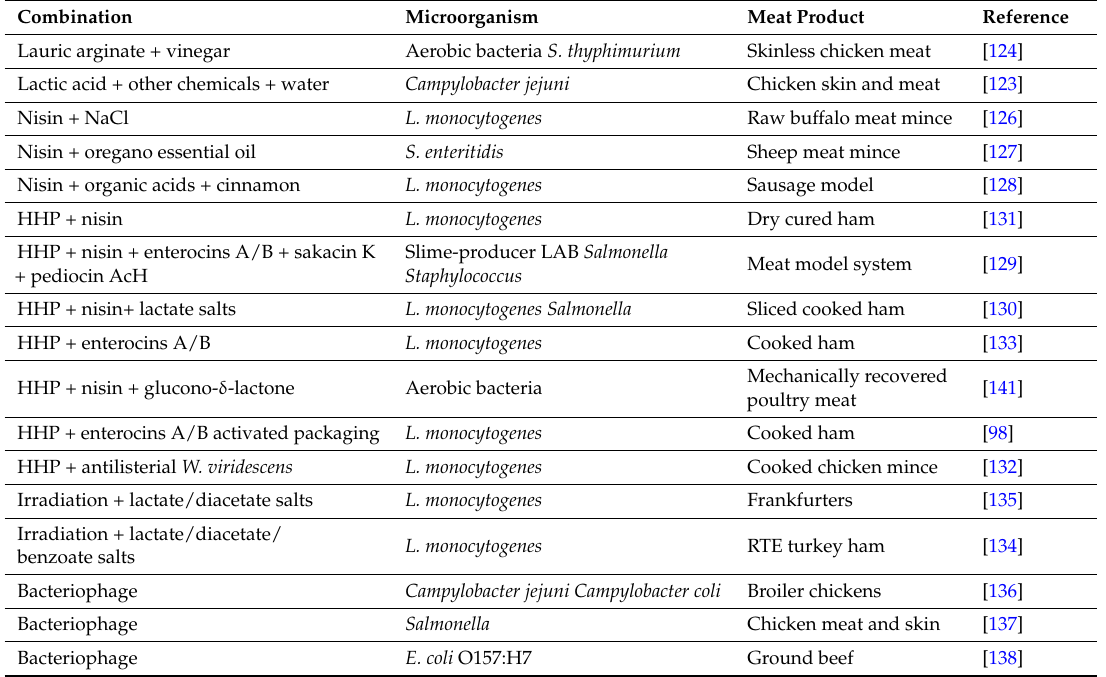
Table 3. Antimicrobial hurdle combinations applied to raw meats, fermented sausages, and cooked/RTE meat